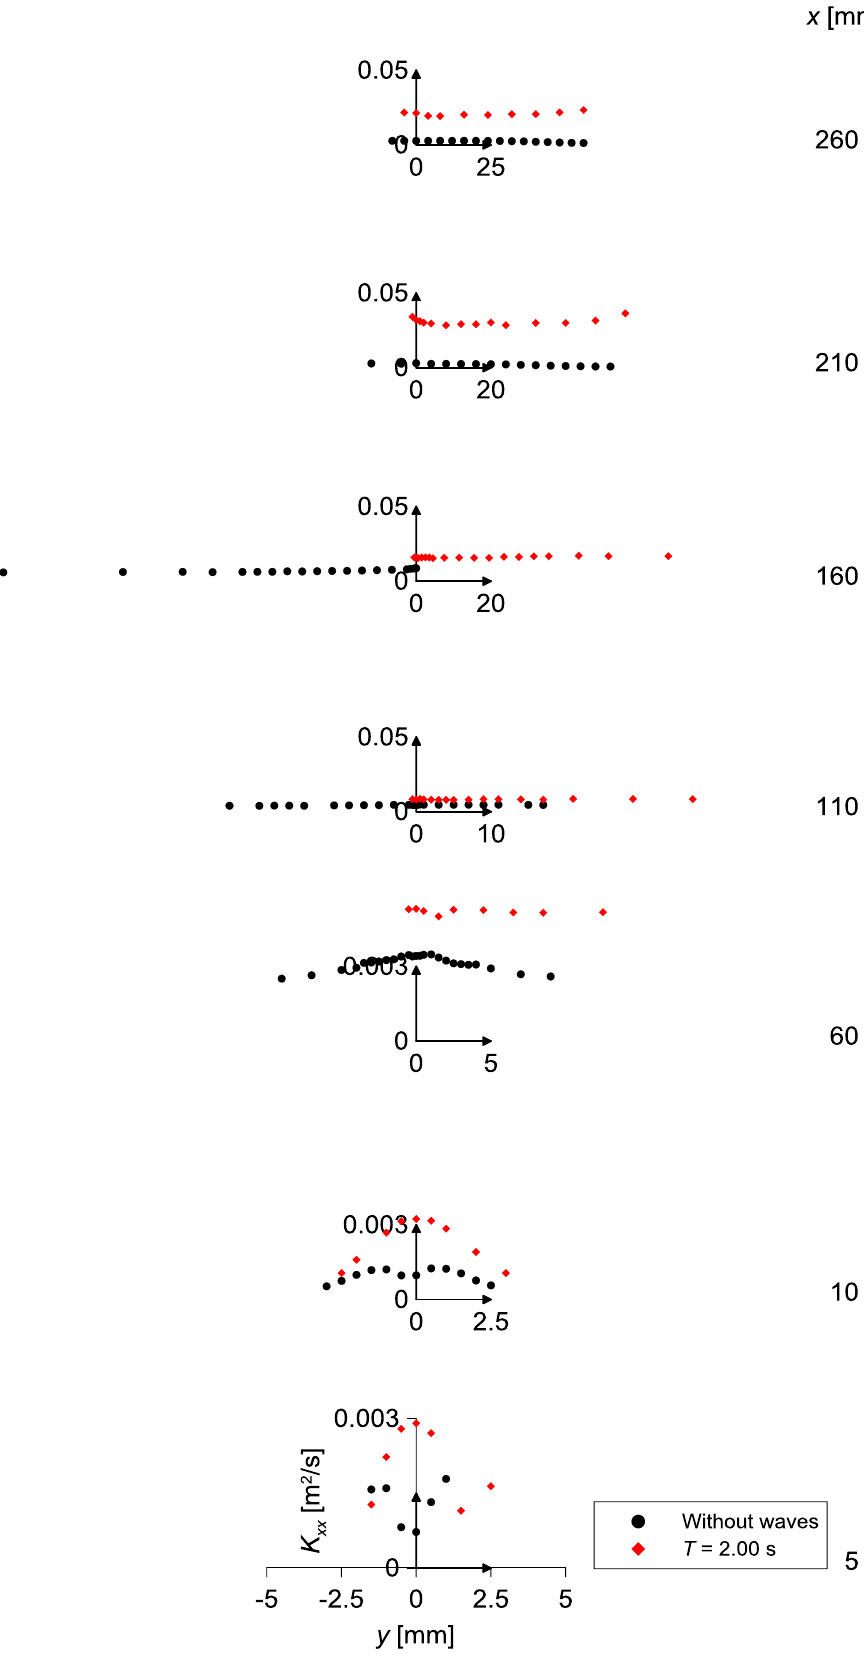
Figure 12. Values of K xx of Run 1 of Table 1 and of the same jet without waves.